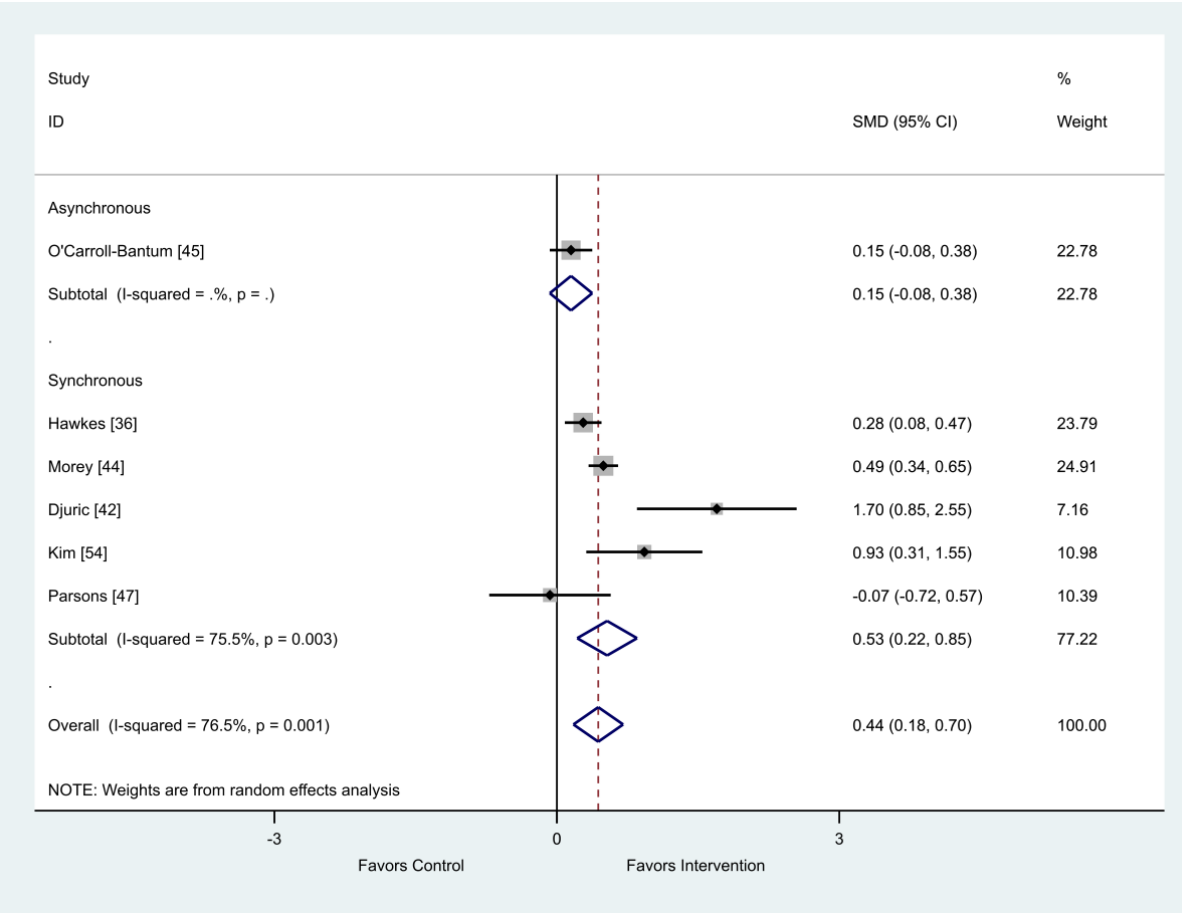
Figure 5. Effect of electronic health interventions compared with control on dietary interventions, analyzed using standardized mean difference. SMD: standardized mean